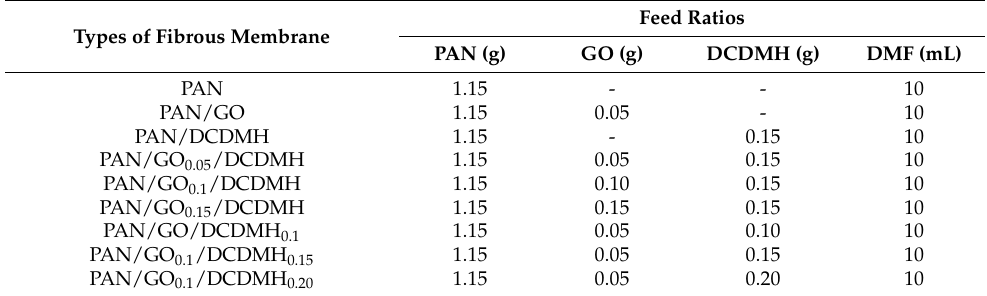
Table 1. The feed ratios of PAN, GO, and DCDMH to DMF in the synthesis of